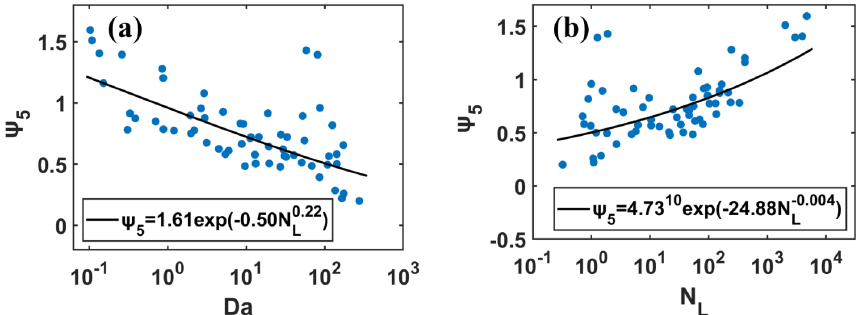
Figure 7. Relationships of the newly defined homogeneous mixing degree ( ψ 5 ) vs. (a) Damköhler number ( Da ) and (b) transition scale number ( N L